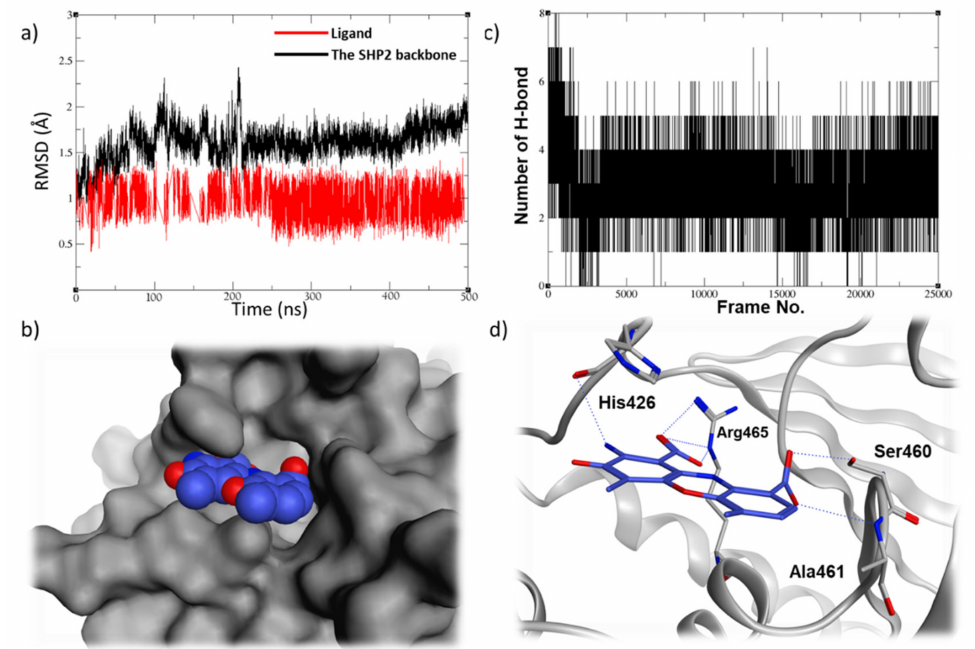
Figure 7. ( a ) The RMSD plot of the 500 ns MD simulations of compound 57774 along with ( b ) the hydrogen bonding plot, ( c ) the top-cluster conformation filling (blue spheres) in the SHP2 active site (gray surface), and ( d ) the ligand 3D binding mode showing the key interactions made with the surrounding